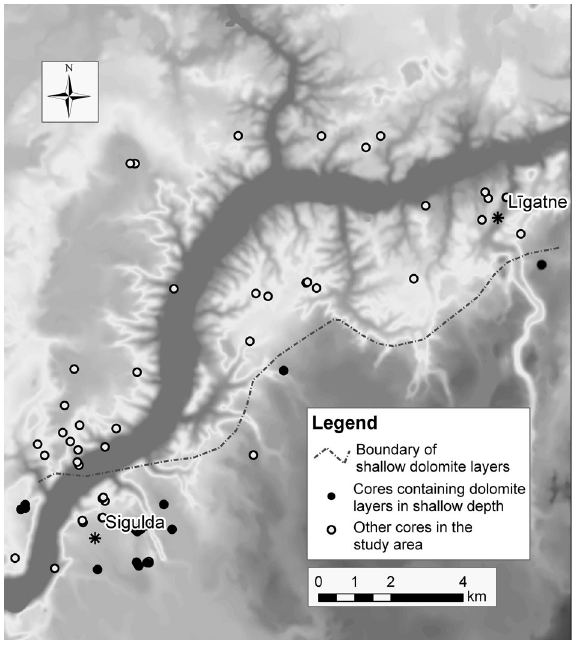
Fig. 9. Structural control of shallow dolomite layers observable in the gully network. Elevation raster data derived from Jarvis et al. (2008). Location of boreholes according to Tak č idi